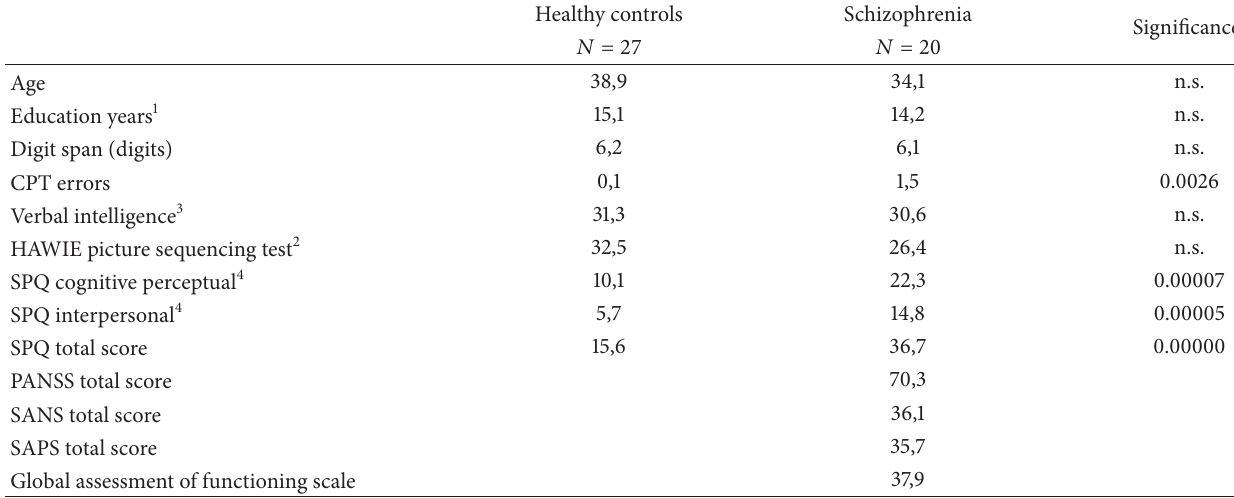
Table 1: Clinical and sociodemographic characteristics of patient and control